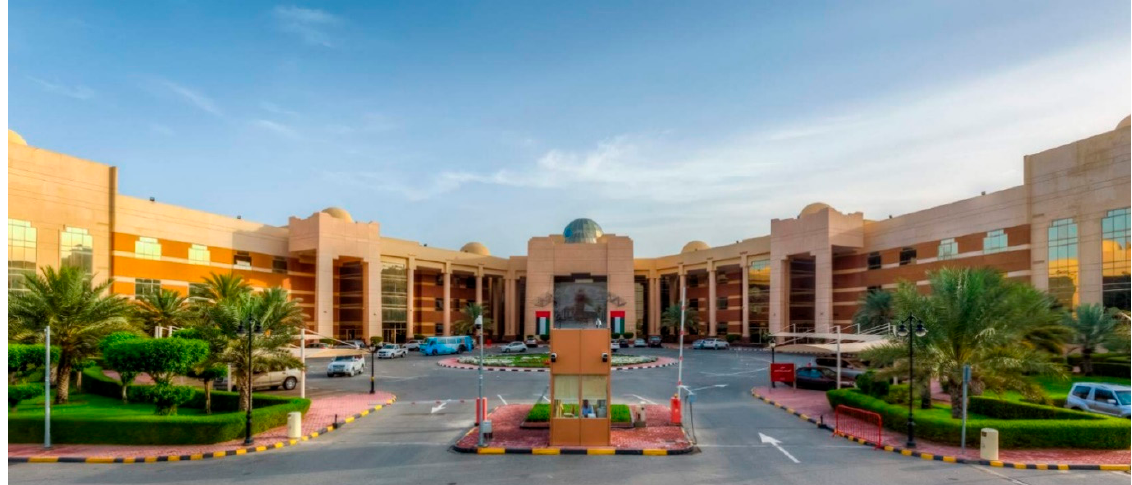
Figure 1. J2 Building at Ajman University in the United Arab Emirates.